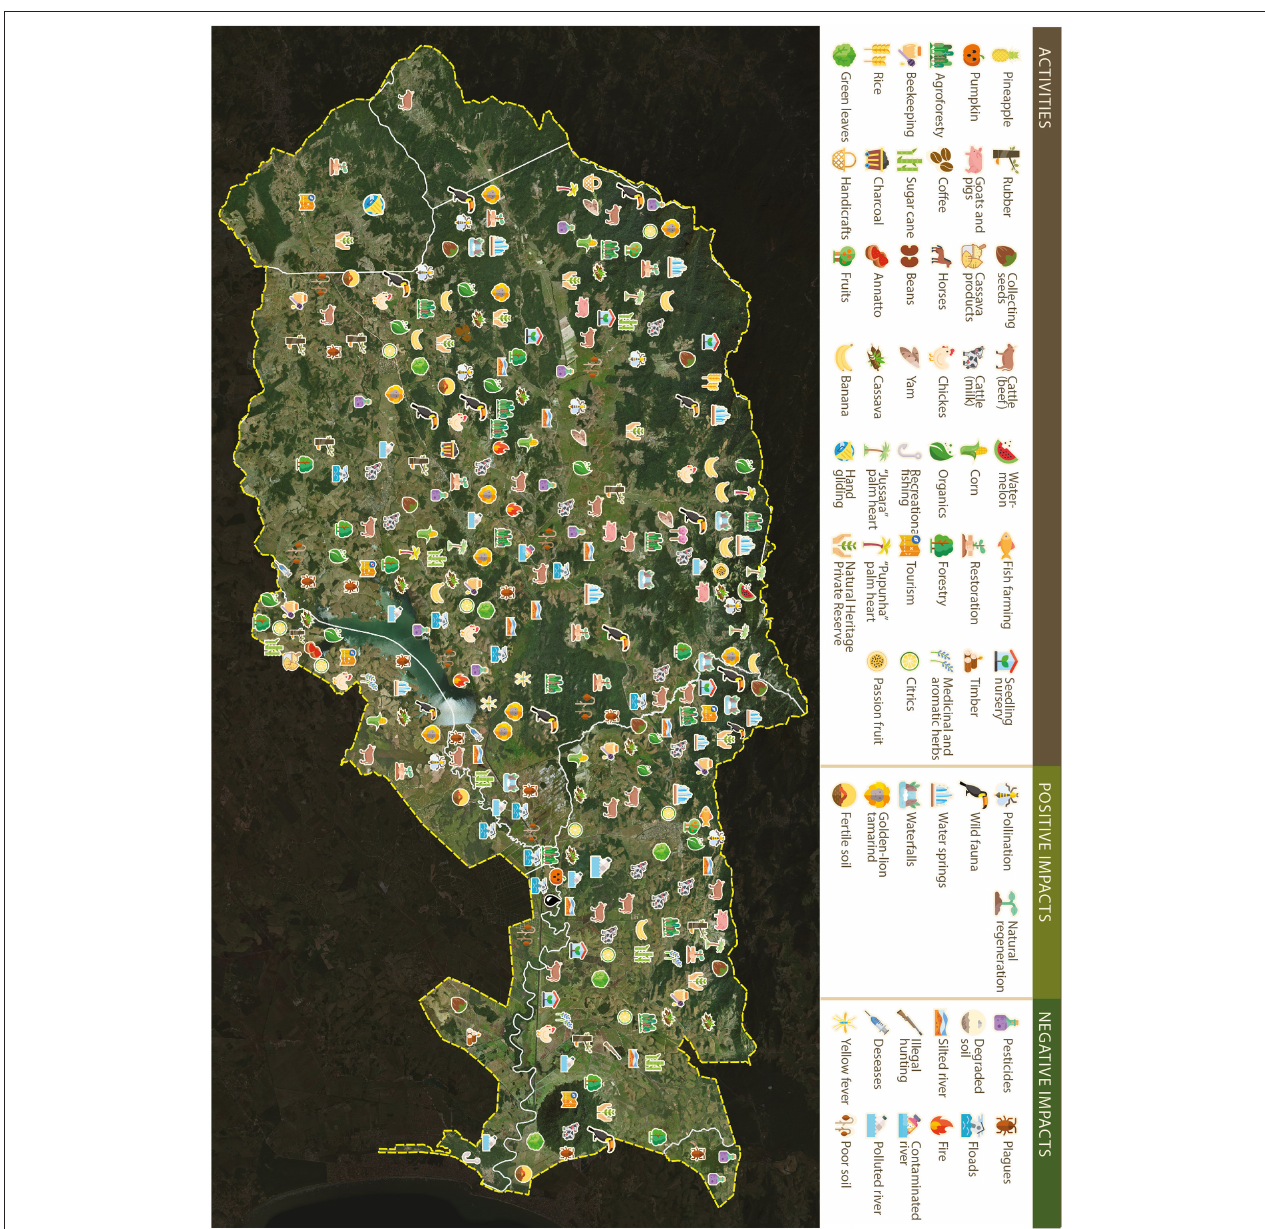
FIGURE 3 | Map of the São João River Basin APA (APA SJ) showing the economic activities and its positive and negative impacts in each region, as identified by local stakeholders in the focus group